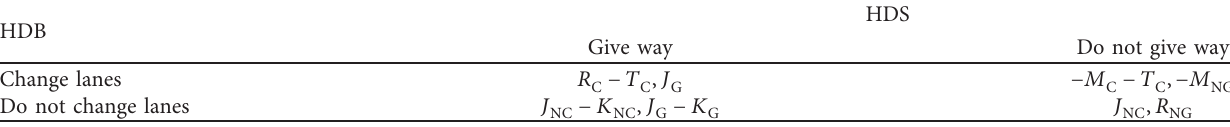
Table 3: Payoff matrix for HDB and